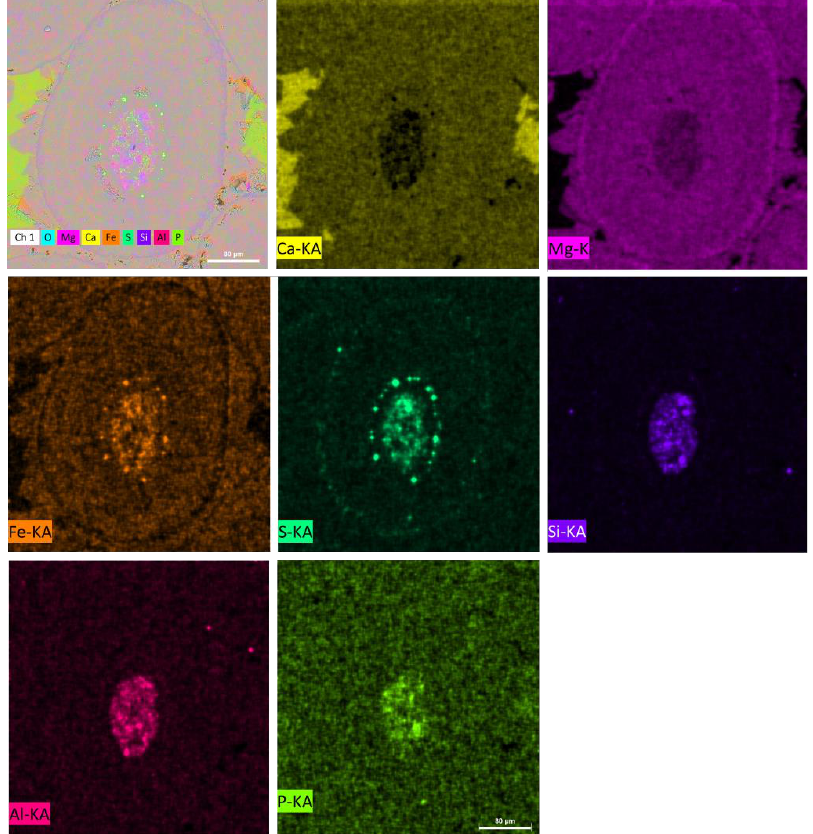
Figure 7. EDS elemental mapping of the ooids from Figure 5a.